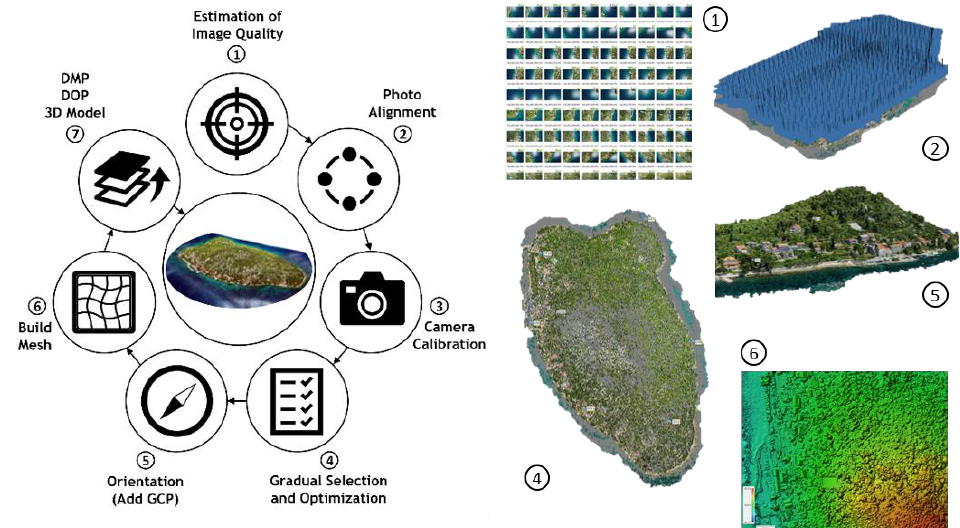
Figure 8. Image workflow process of UAV imagery.